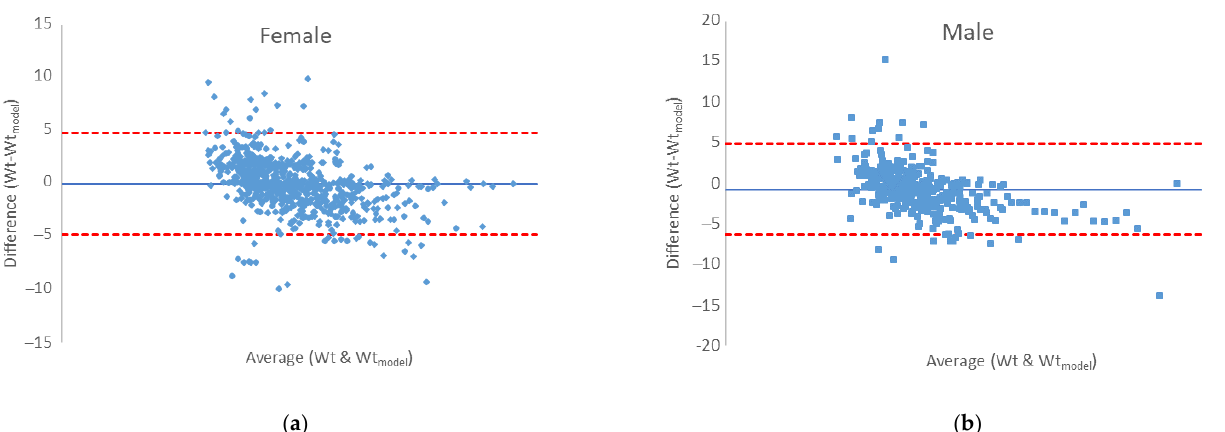
Figure 4. Bland – Altman plot for body mass of different phases of ketogenic diet for ( a ) female and ( b ) male subjects.